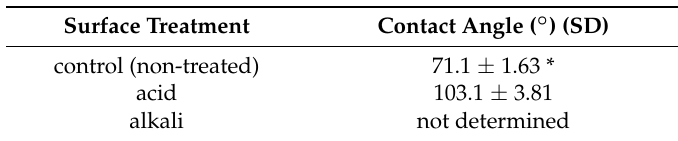
Figure 4. The shapes of the water drops applied to each sample. ( a ) Control; ( b ) Acid; ( c ) Alkali group. Table 3. Contact angle.